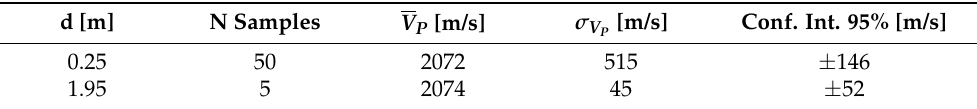
Figure 11. Typical values recorded by the accelerometers in the direct tests on the masonry panel. Table 3. Direct impact tests results: distance between the measurement points d ; number of suitable samples used in the analysis; mean of P-waves velocity V P ; standard deviation of P-waves velocity σ V ; interval of P-waves velocity with a confidence level of 95%.